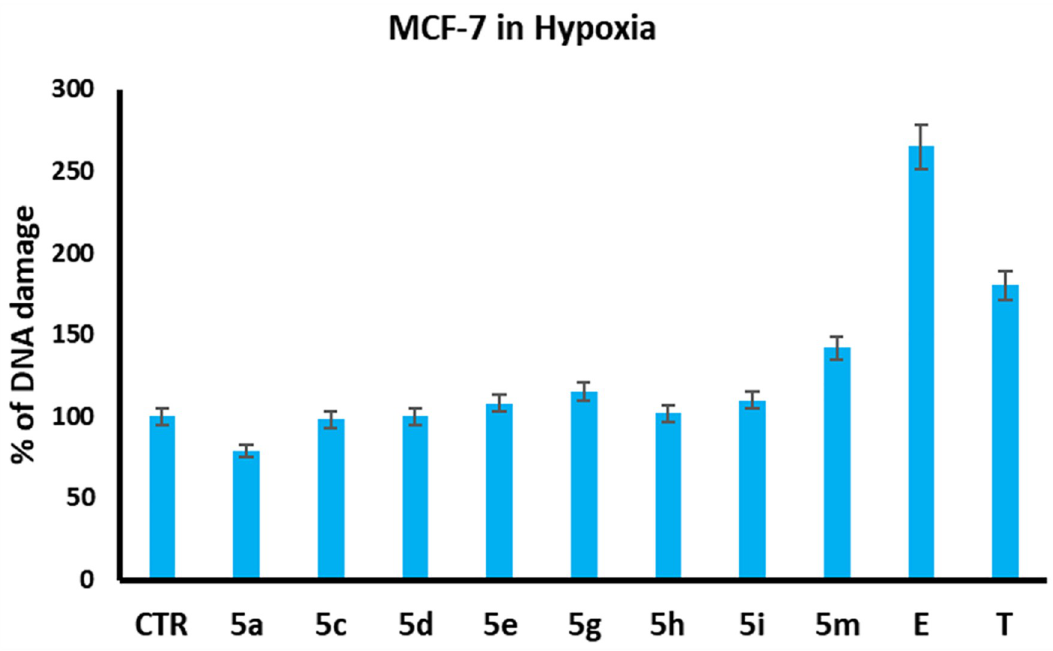
Fig 4. Effect of selected fuberidazole derivatives on DNA damage in hypoxic MCF-7 cells, CTR (control), E (etoposide), and T (tirapazamine). The control sample (CTR) included MCF-7 cells that had not been exposed to the substances under study. Statistical data: mean and standard deviation of trials are represented as n = 3.